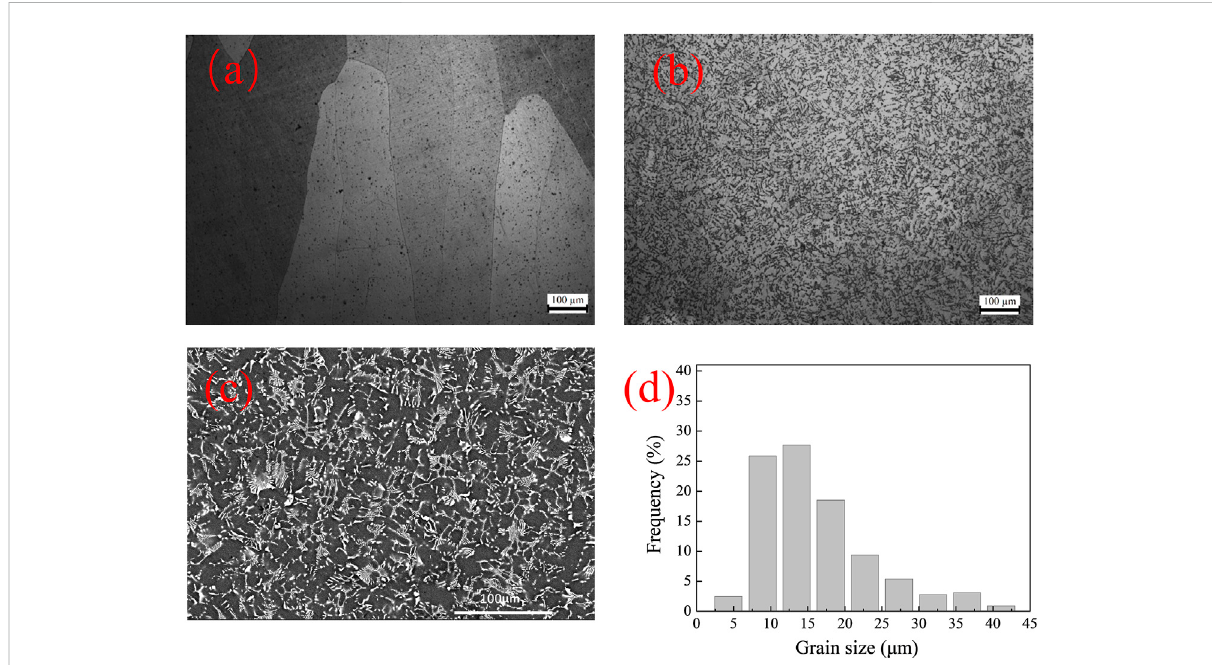
FIGURE 1 Microstructureofas-castalloys. (A) Opticalmicrographoftheas-castL14. (B) as-castLT146. (C) SEMmicrographofas-castLT146, (D) statistical grain size distribution of as-cast